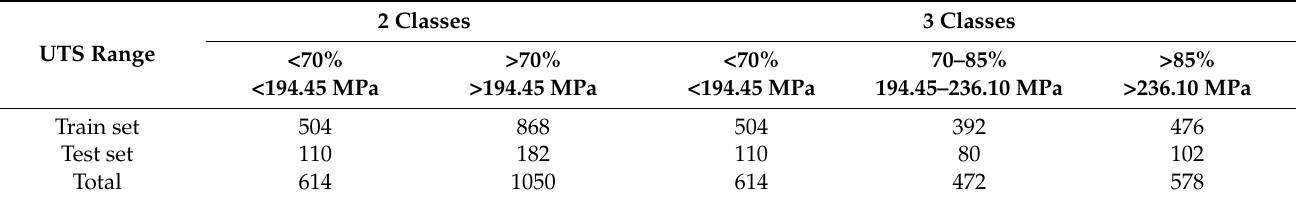
Table 2. Characteristics of our proposed dataset.